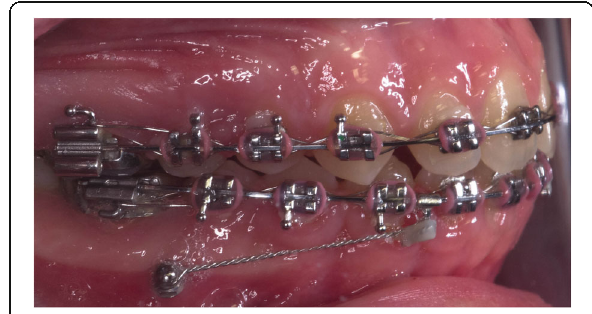
Fig. 1 Intra-oral lateral view with mini-implants inserted between the lower second premolar and first molar, ligated to crimpable hook on the arch wire (mini- implant